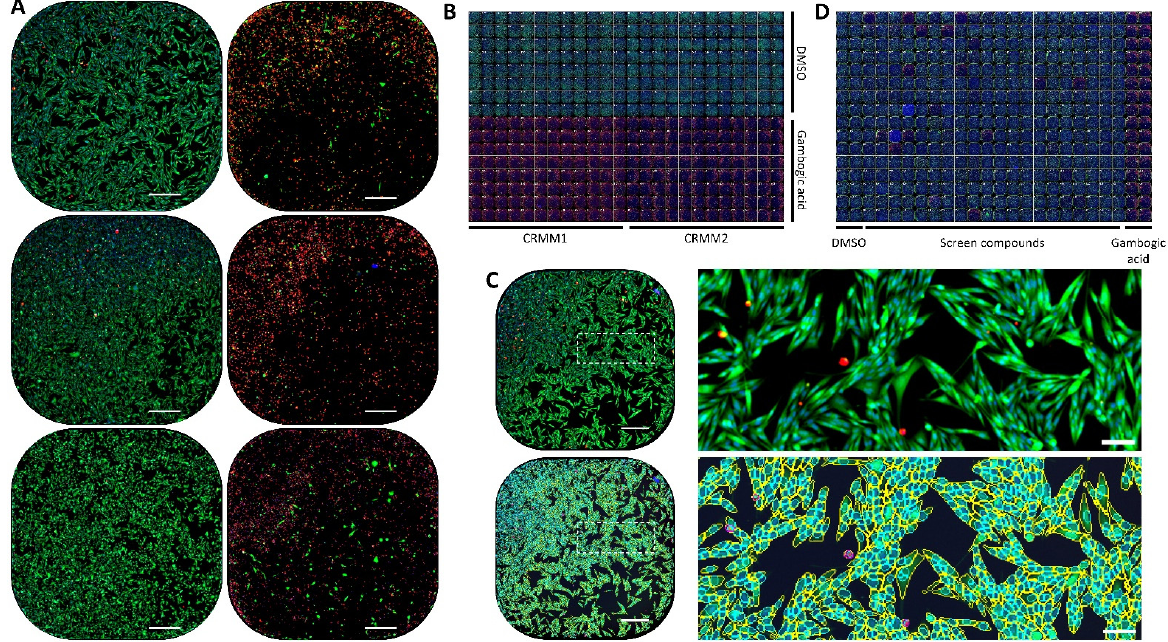
Figure 1. Live/Dead viability/cytotoxicity assay screen. ( A ) Example images of the control conditions for all 3 conjunctival melanoma cell lines. Upper row: CRMM1; middle row: CRMM2; lower row: CM2005.1. Left: DMSO; Right: Gambogic Acid. All nuclei are stained blue with Hoechst 33342, live cells, green with Calcein AM, and dead nuclei red with Ethidium homodimer-1. Objective 4×/0.2. The full well area is contained in a single image per well. Scale bar 500 µm. ( B ) Full plate snapshot of the Z’ plate validating the assay for CRMM1 and CRMM2 cell lines. All images of the plate, acquired in the same conditions as in ( A ), are montaged together. ( C ) Image segmentation performed with CellProfiler. DMSO control image of CRMM1 cells stained as in ( A ) (top row), and with the overlays of segmented regions (bottom row). Cyan: all nuclei. Yellow: live Calcein AM-positive cells. Pink: dead Ethidium homodimer-1-positive nuclei. Right: zoomed crop of the area highlighted by a dashed rectangle. Scale bars 500 µ m (left) and 100 µ m (right). ( D ) Full plate snapshot example of one of the screen plates with CRMM1 cells, composed of 32 replicates of each of the controls and 320 screen compounds, montaged together after imaging as in ( A